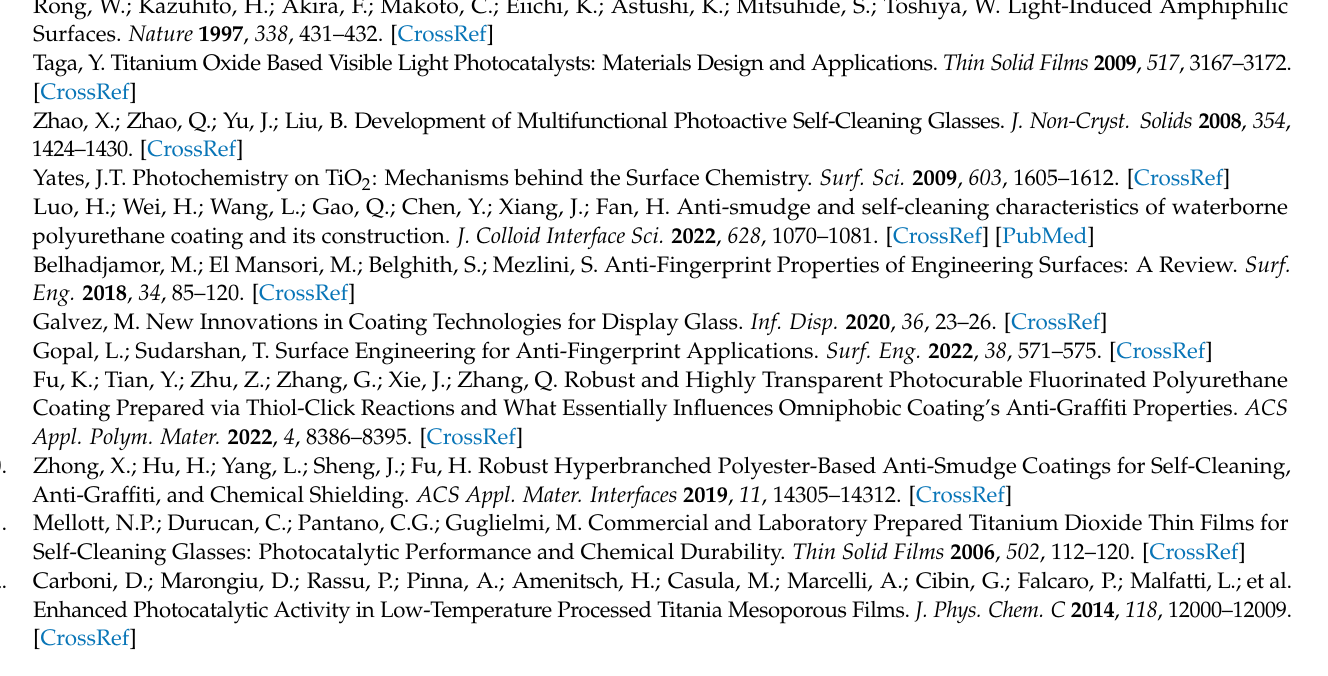
Figure S5. Contact angle images. References [63,64] is cited in the supplementary